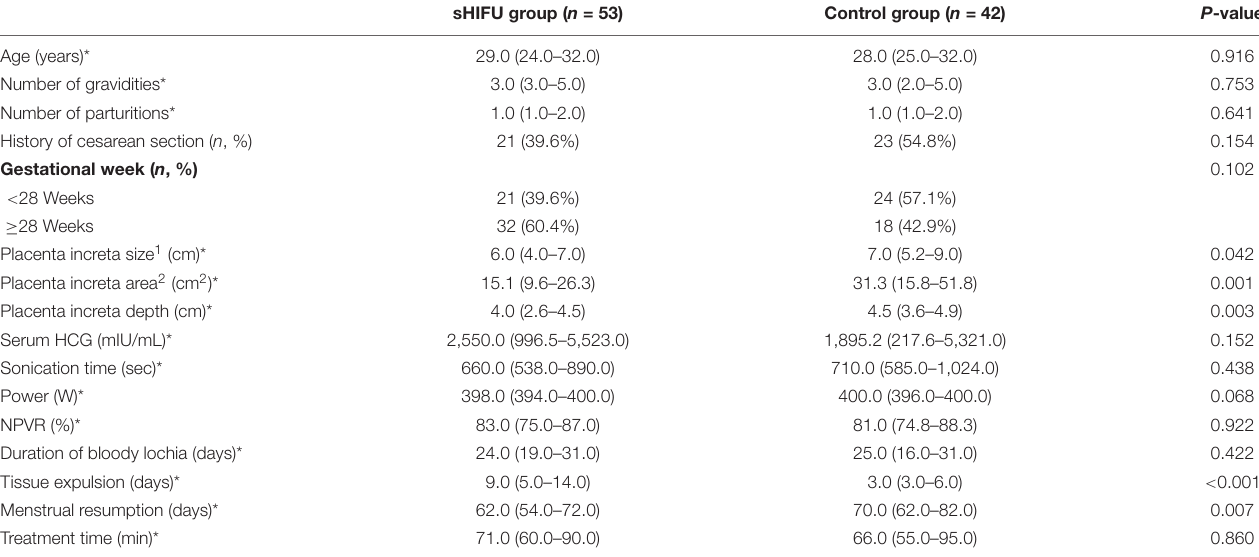
TABLE 1 | Comparison of clinical characteristics of patients in two groups.